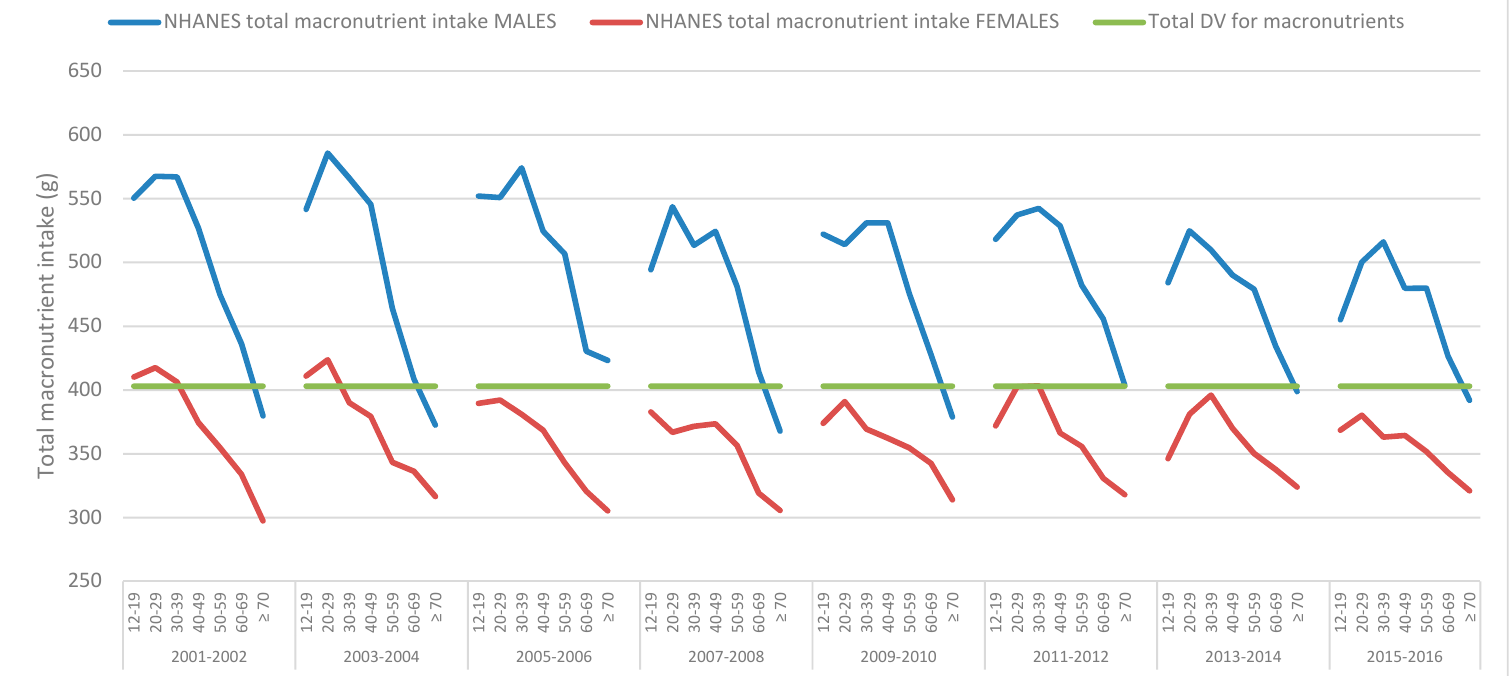
Figure 1. Mean daily total macronutrient intakes, from food, derived from the National Health and Nutrition Examination Survey (NHANES) 2001–2016 data, across various age groups for males and females and the total macronutrient suggested by the Daily Values (DV).